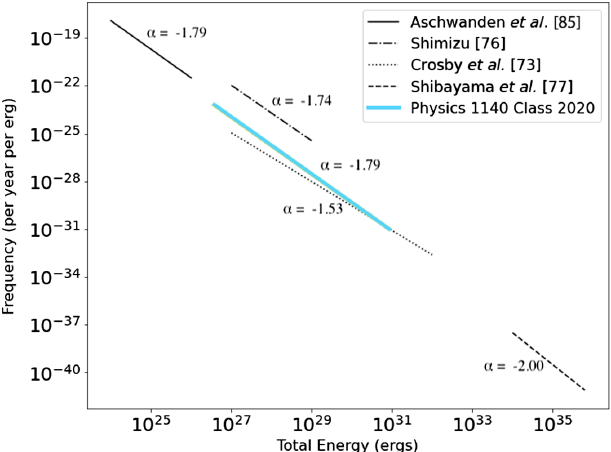
FIG. 3. The flare frequency distribution calculated by the Fall 2020 semester of the PHYS-1140 course compared to findings from related studies. The other papers look at flares from the smallest scale (so called “ nanoflares ” observed on the sun) up to “ superflares ” observed on other